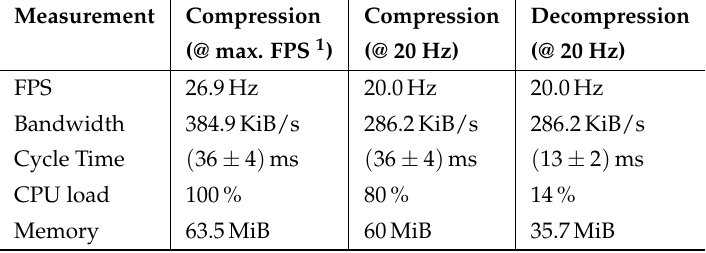
Table 5. Compression and decompression performance when using 4cm octree